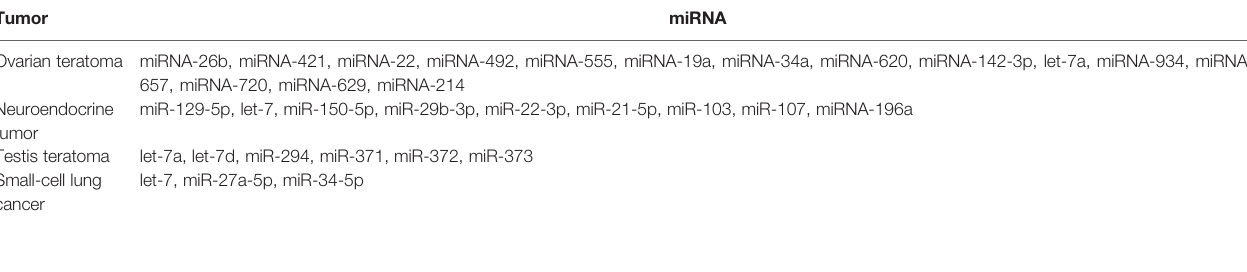
TABLE 4 | miRNA biomarkers for tumors related to anti-NMDA receptor encephalitis (9). Tumor